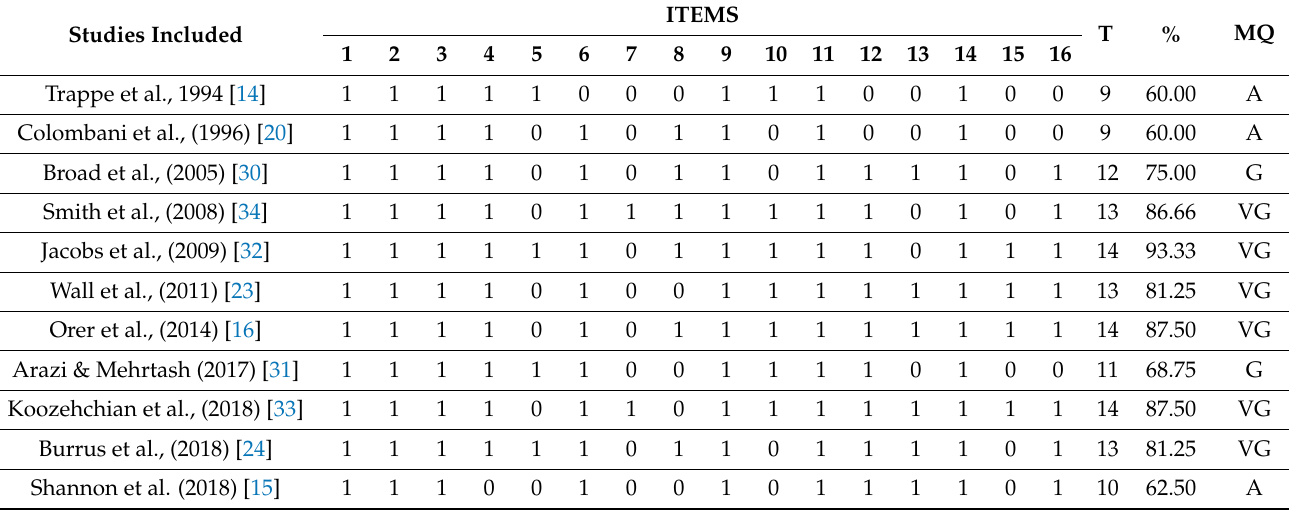
Table 1. Methodological quality of the studies included in the review by McMaster Critical Review Form for Quantitative Studies. Studies